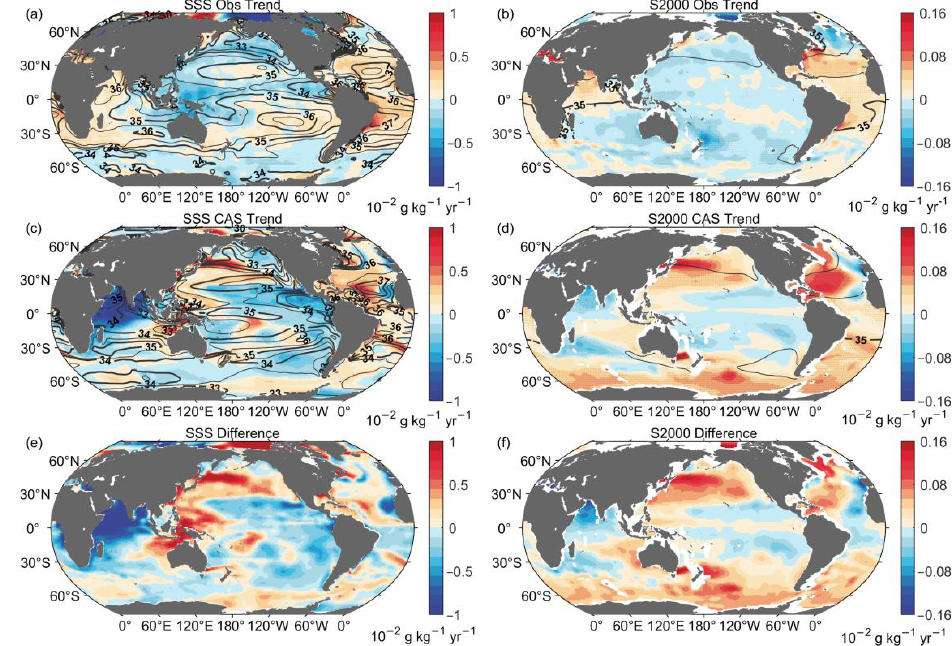
Figure 5. Linear trends of the ( a ) sea surface salinity (SSS) and ( b ) 0 – 2000 m averaged salinity (S2000) anomalies during 1960 – 2020 for the observational mean, ( c , d ) for the CAS-ESM2-0 model. The anomalies are relative to the 1990 – 2010 baseline. The stippling indicates the regions with statically significant signals (95% confidence level). Mean differences between the model and observational mean for the ( e ) SSS and ( f ) S2000.